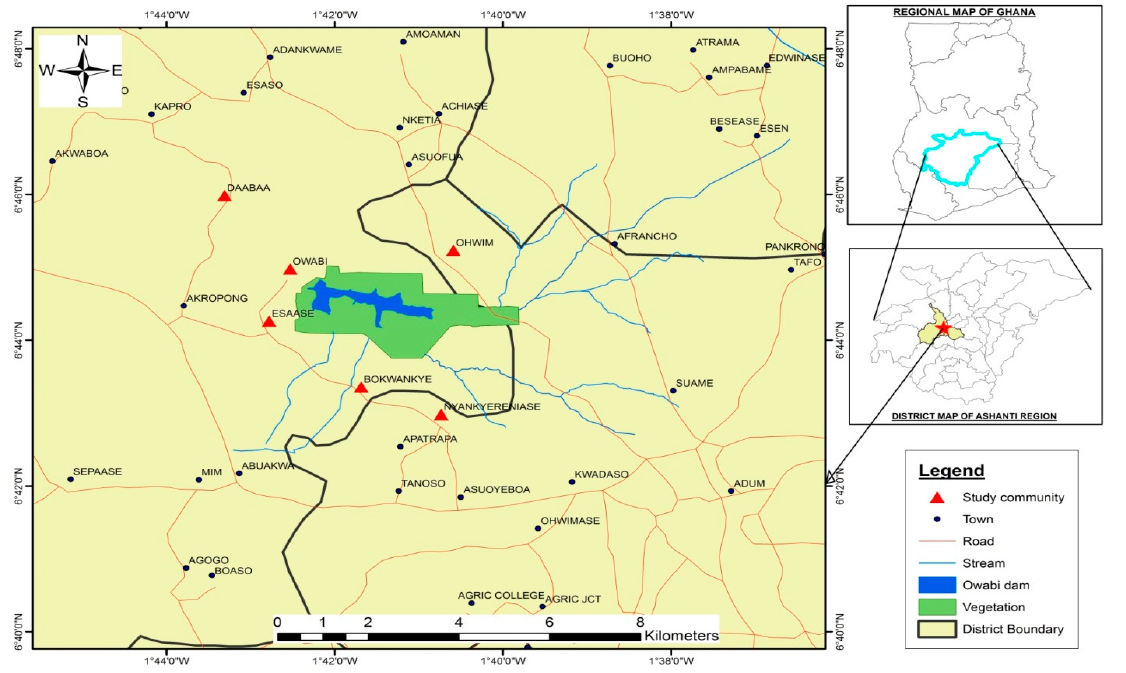
Figure 1. Map of the Owabi catchment showing the study communities.